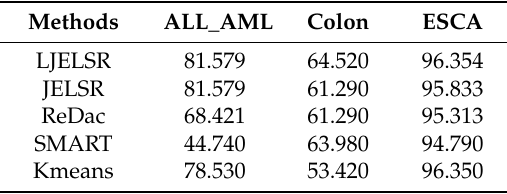
Table 9. ACC of different methods for different